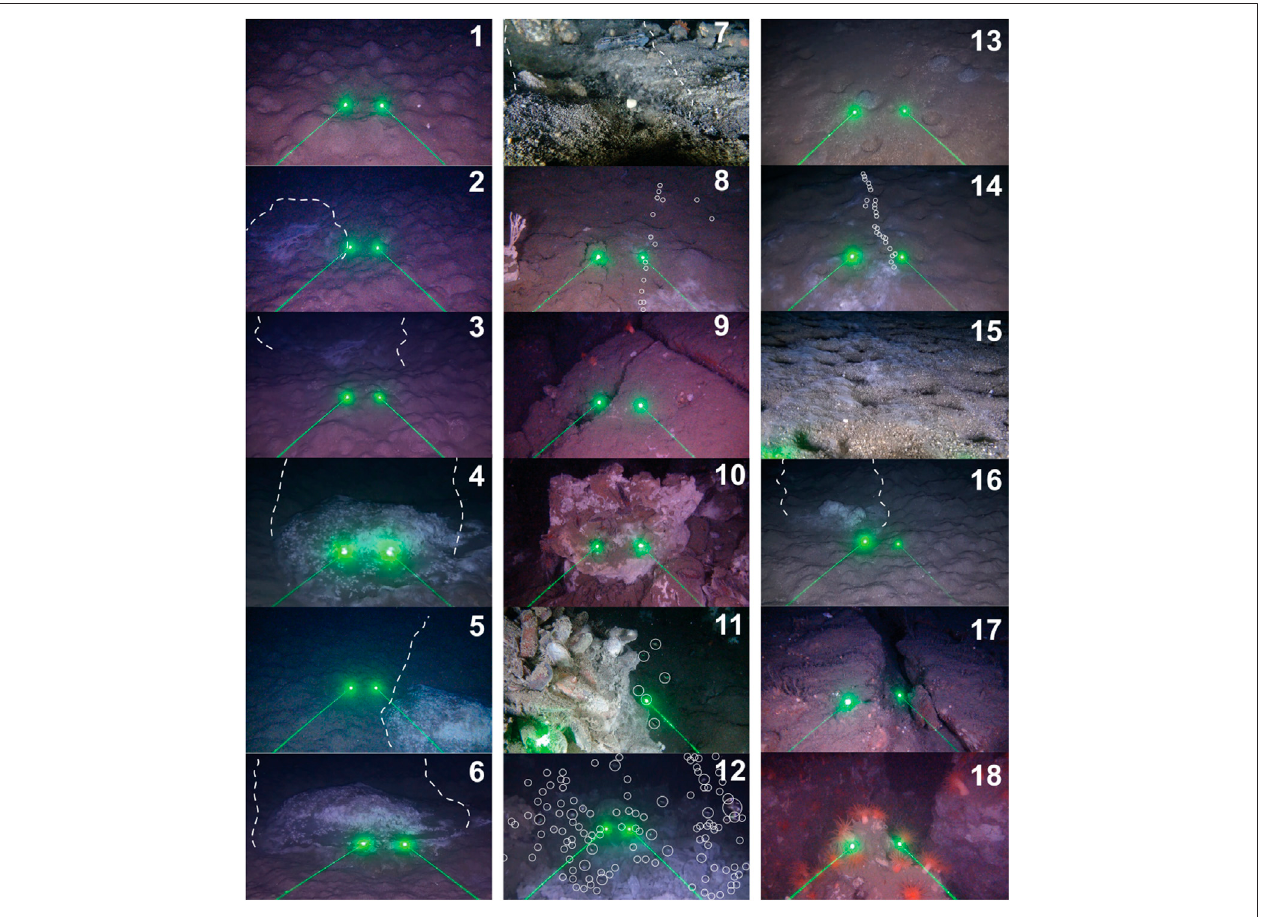
FIGURE 9 | Still images for three features of interest (FOI; see Figure 1B for FOI locations). Numbers correspond to approximate locations along towed camera transects in Figure 8 . White dashed lines highlight where fl uid was observed exiting the sea fl oor; white circles highlight observable bubbles.